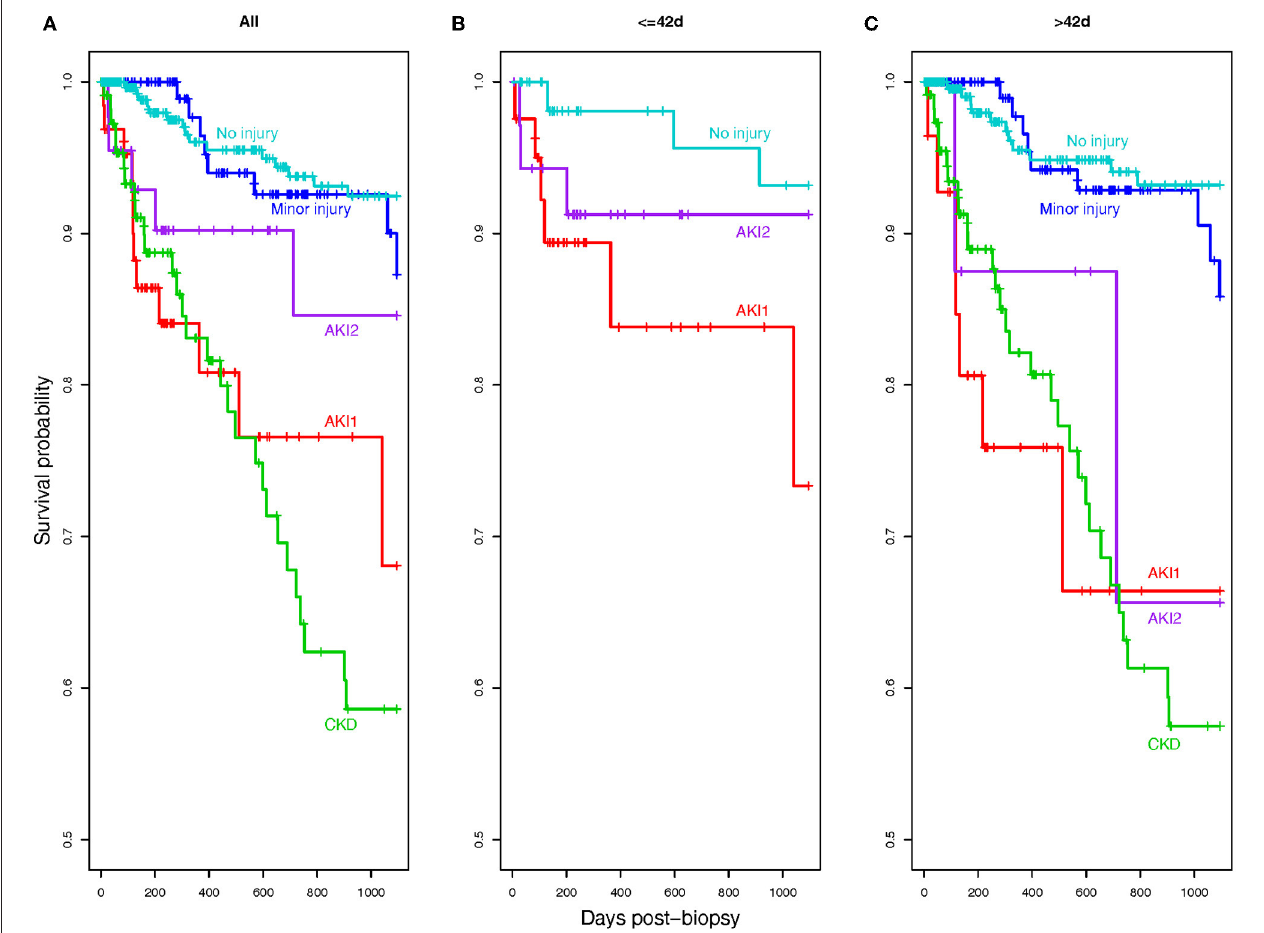
FIGURE 3 | Kaplan-Meier curves showing actuarial 3-year death-censored graft survival in the injury AA groups after excluding all biopsies with rejection. (A) Injury AA groups were compared across time post-biopsy. We also examined the differences between, (B) short-term ( ≤ 42 days post-biopsy), and (C) long-term ( > 42 days post-biopsy) survival probabilities. The CKD/AKI group was removed from these plots due to the very small group size and scarcity of